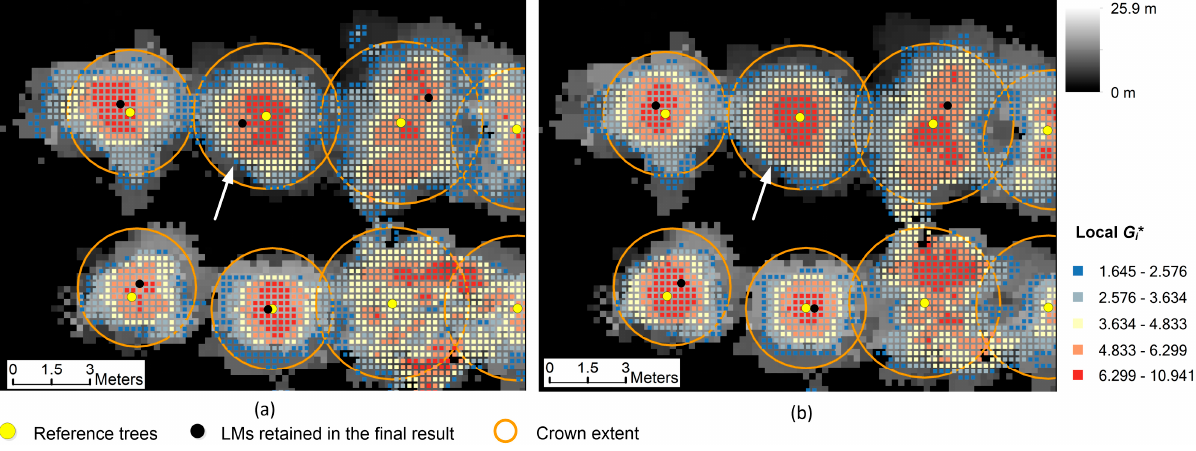
Figure 13. Tree detection results derived by using the 9th and 10th combinations of parameter values in Table 3: ( a ) the result generated by using the 9th combination; ( b ) the result generated by using the 10th combination. The CHM with a 0.25 m resolution is displayed. The cells extracted through significance tests are shown in different colors according to the local G i * values on each cell.